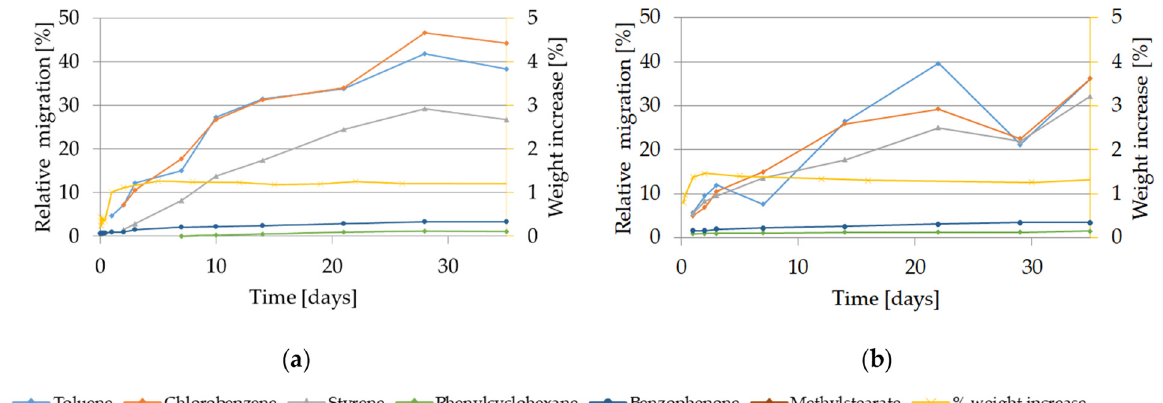
Figure 7. Migration kinetics and weight increase in 50% ethanol at 60 °C: ( a ) Model substances and styrene from GPPS; ( b ) Model substances and styrene from HIPS. Note: Due to analytical interferences, migration of methyl stearate from GPPS and HIPS in HIPS in 50% ethanol at 60 °C can not be measured.